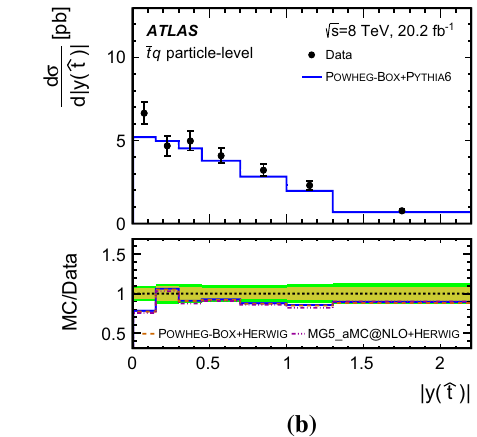
data points denote the total uncertainty. The inner ( yellow ) band in the bottom part of each figure represents the statistical uncertainty of the measurement, and the outer ( green ) band the total uncertainty